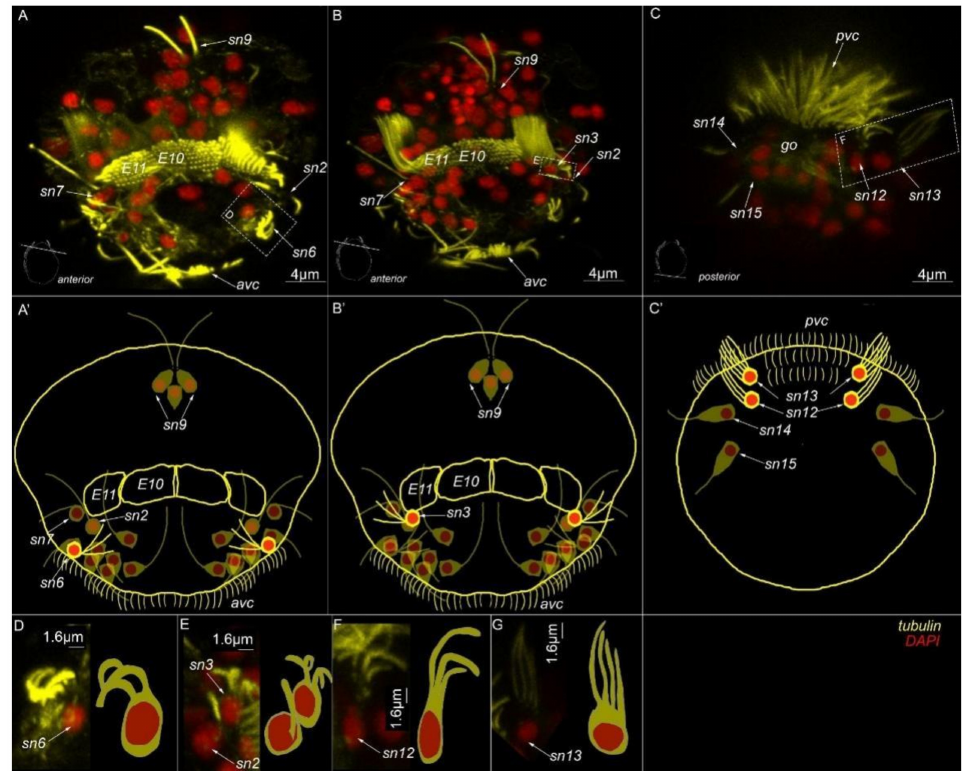
Figure 7. Type 1c sensory neurons in mature Dimorphilus gyrociliatus dwarf male revealed by anti- acetylated alpha-tubulin labeling. ( A ) Anterior surface view. ( A (cid:48) ) Schematic representation of the anterior surface. ( B ) Anterior surface view. ( B (cid:48) ) Schematic representation of the anterior surface. ( C ) The posterior surface view. ( C (cid:48) ) Schematic representation of the posterior surface view. ( D ) The close-up and drawing of sensory neuron № 6. ( E ) Close-up and drawing of sensory neuron № 3. ( F ) Clode-up and schematic drawing of sensory neuron № 12. ( G ) Close-up and schematic drawing og sensory neuron № 13. Abbreviations: E10, 11 —multiciliated cells of the dorsal ciliary field; dc —dorsal cilia; pvc —posterior cilia; sgd —stylet gland cell; sn1–sn20 —sensory neurons